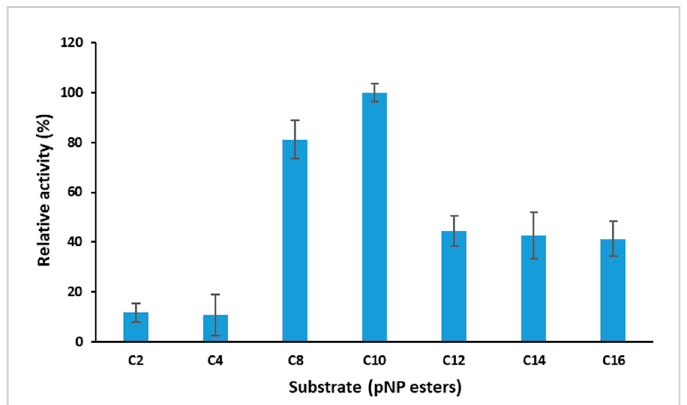
Figure 6. Effect of different pNP esters on purified GlaEst12 esterase. The activity of esterase was measured using different pNP esters at 60 °C using 50 mM Tris-HCl pH 8. The highest activity with p-nitrophenol decanoate (C10) substrate is shown as 100%. Error bar represents standard deviation ( n = 3).